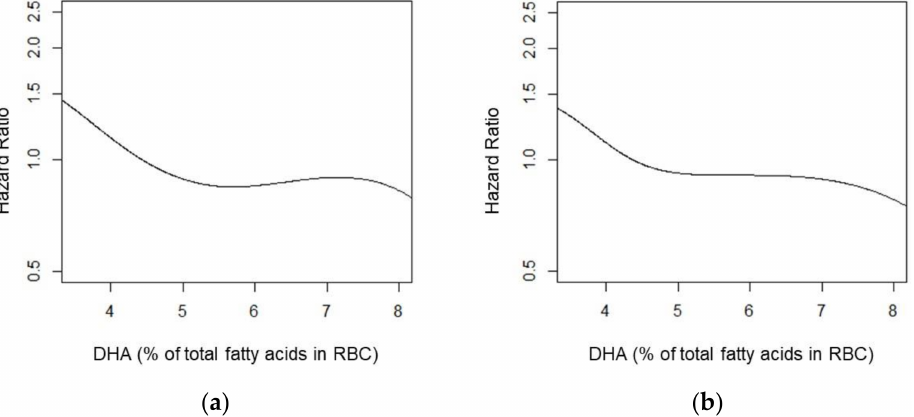
Figure 4. Spline for red blood cell DHA and Alzheimer’s disease ( a ) and all-cause dementia ( b ). Model adjusted for age, sex, APOE- ε 4 carriership, education, diabetes status at baseline, and prevalent cardiovascular disease at